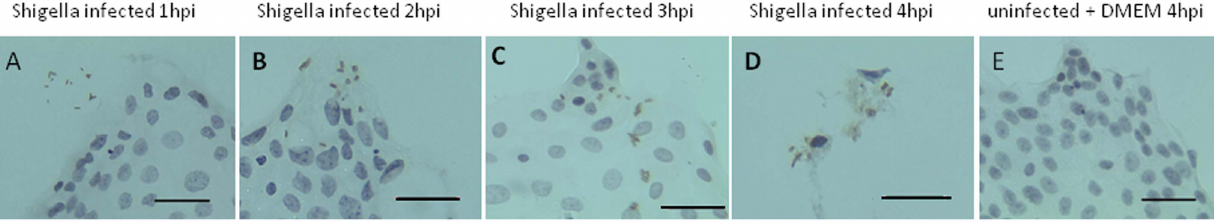
Figure 6. Immunohistochemistry of the primary chicken intestinal epithelial cells infected with the Shigella strain ZD02. Uninternalized bacteria (brown staining) were seen near the epithelial cells at 1 h post-inoculation (A). Internalized bacteria (brown staining) were found at 2 h (B) and 3 h (C). The lysed epithelial cells released bacteria (brown staining) at 4 h (D). Uninfected epithelial cells were shown as control (E). Scale bars=20 m